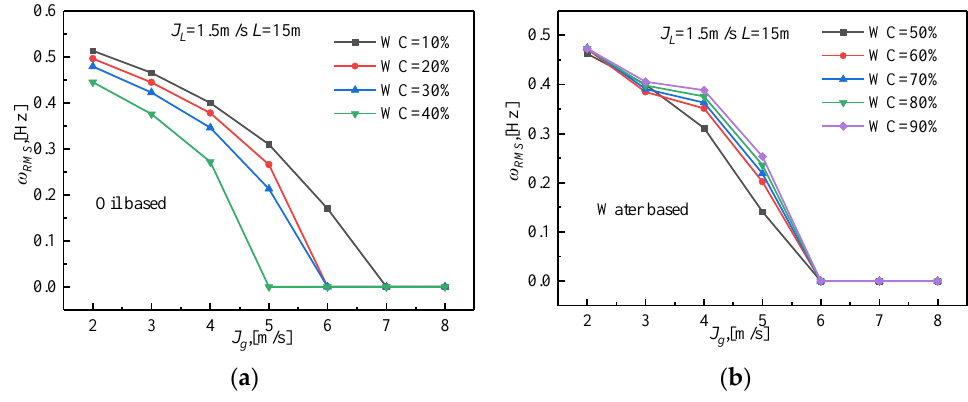
Figure 10. Variations of ω RMS and R RMS with J g and L in the first mode . As can be seen from Figure 11a, the critical gas velocity is equal to 7 m/s at WC = 10% and that as WC increases to 40%, the critical gas velocity decreases to 5 m/s. However, in the water-based slug flow state, WC has little effect on the critical gas velocity, which is 6 m/s within the range of 50 – 90% WC, as can be seen in Figure 11b. The minimum critical gas velocity occurs at WC = 40%. In order to ensure the stable operation of the pipeline, it is necessary to avoid the flow conditions near the phase inversion zone.